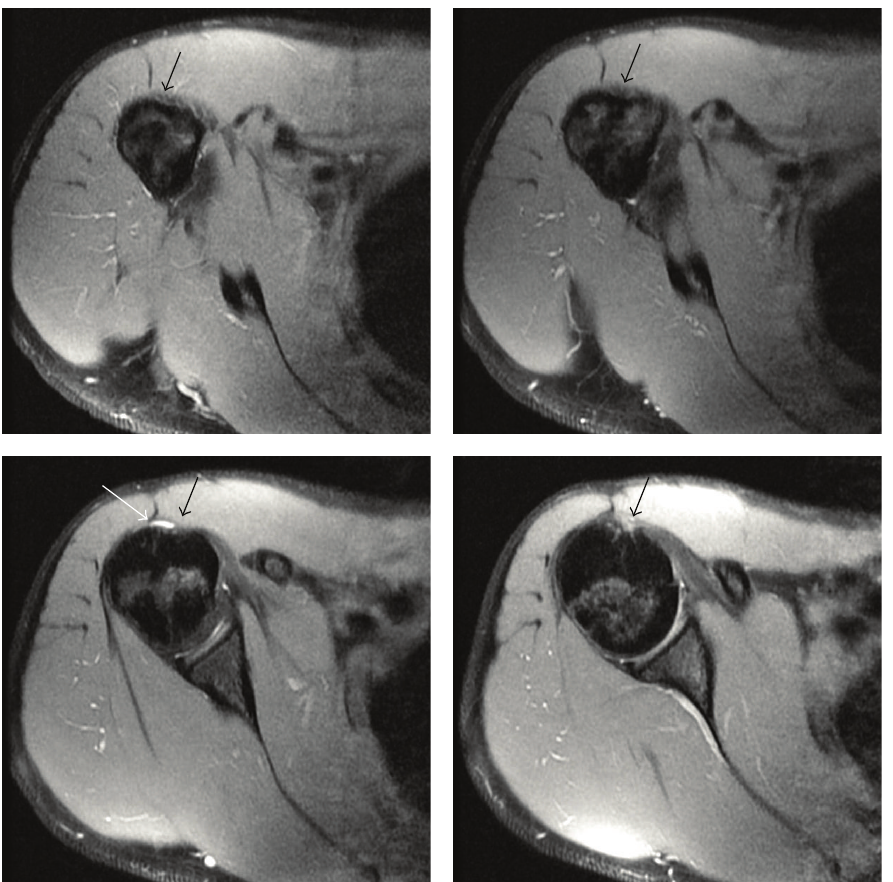
Figure2:AxialDPFSSEMRsequentialimagesoftherightshoulder(TR=2540;TE=11.18;NEX=2;EC=1)demonstratingashallowbicipital groove (black arrows) and absence of the long head of the biceps tendon. There is a small amount of fluid in the subacromial/subdeltoid bursa (white arrow), without pathologic